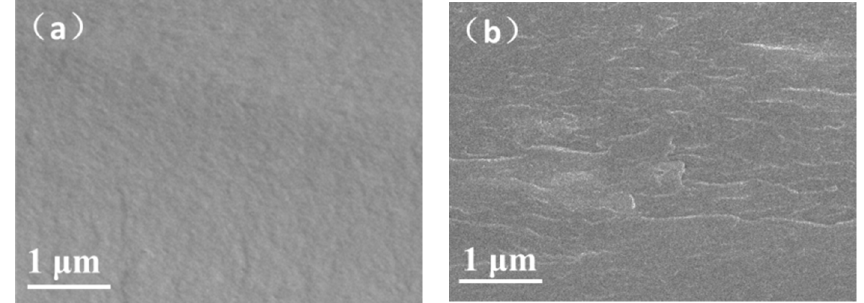
Figure 4. SEM images of cross-sections of ( a ) CS and ( b ) CS/QMXene-NH 2 -7.5.